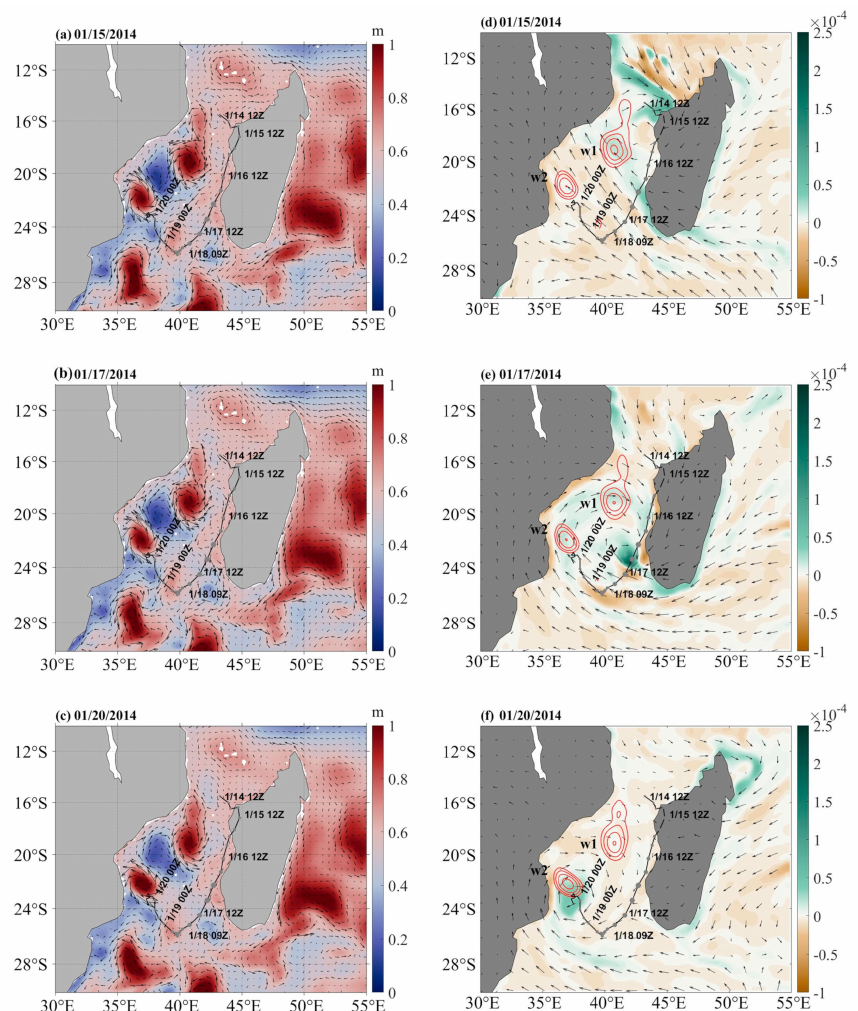
Figure 3. Changes in the marine environmental field during the TS. ( a – c ) Changes in the sea surface height and flow field on 15, 17 and 20 January. ( d – f ) are the wind field and change in EPV on 15, 17 and 20 January and the positive (negative) value is upwelling